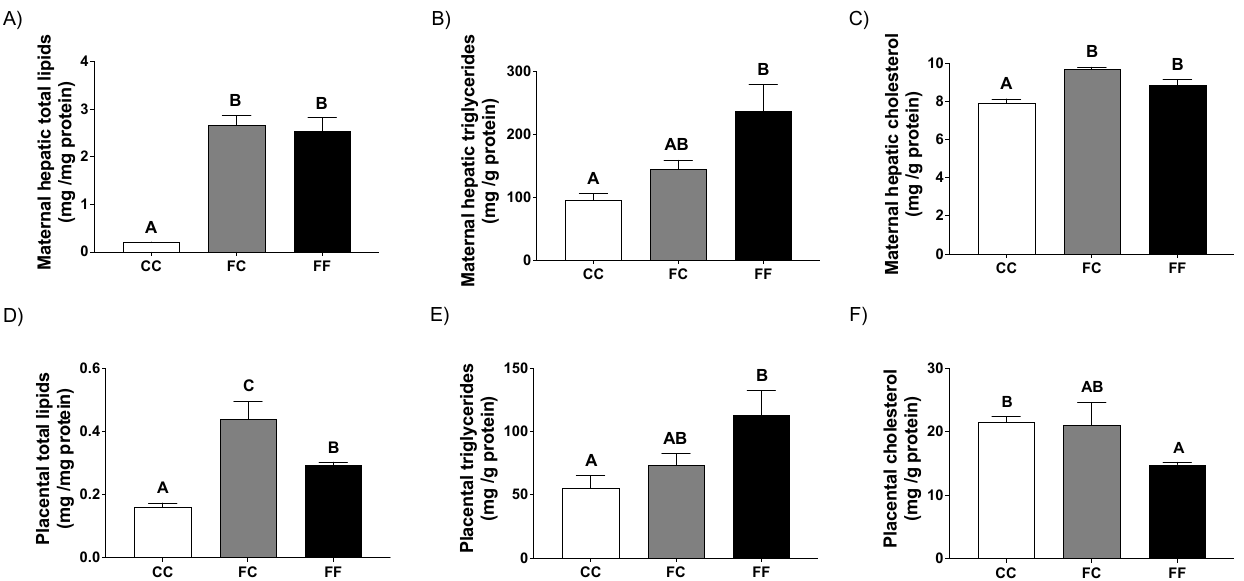
Figure 3. Pregnancy in progeny from fructose-fed mothers and ingestion of a 10% wt/vol fructose solution throughout gestation in pregnant rats from fructose-fed mothers influence maternal liver and placental lipid accumulation. Hepatic content of ( A ) total lipids, ( B ) triglycerides, and ( C ) cholesterol of 21-day-pregnant rats from control mothers (CC, empty bar), or pregnant rats from fructose-fed mothers subjected (FF, black bar) or not (FC, grey bar) to fructose intake throughout pregnancy. Placental content of ( D ) total lipids, ( E ) triglycerides, and ( F ) cholesterol of 21-day-pregnant rats from control mothers (CC, empty bar), or pregnant rats from fructose-fed mothers subjected (FF, black bar) or not (FC, grey bar) to fructose intake throughout pregnancy. Data are mean ± S.E. from 5 pregnant rats. Values not sharing a common letter are significantly different ( p < 0.05) between the three groups.